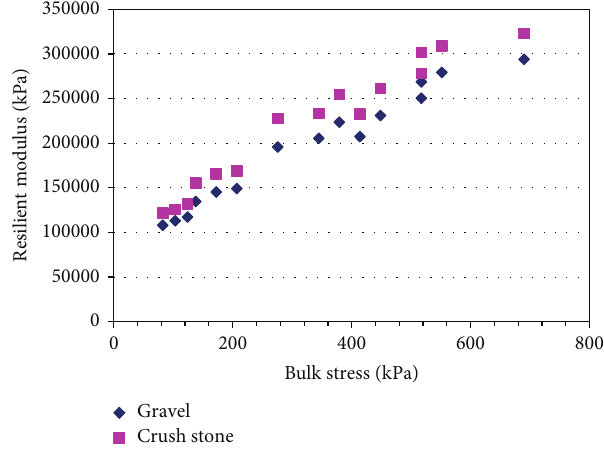
Figure 5: Laboratory resilient modulus for gravel and crush stone at bulk